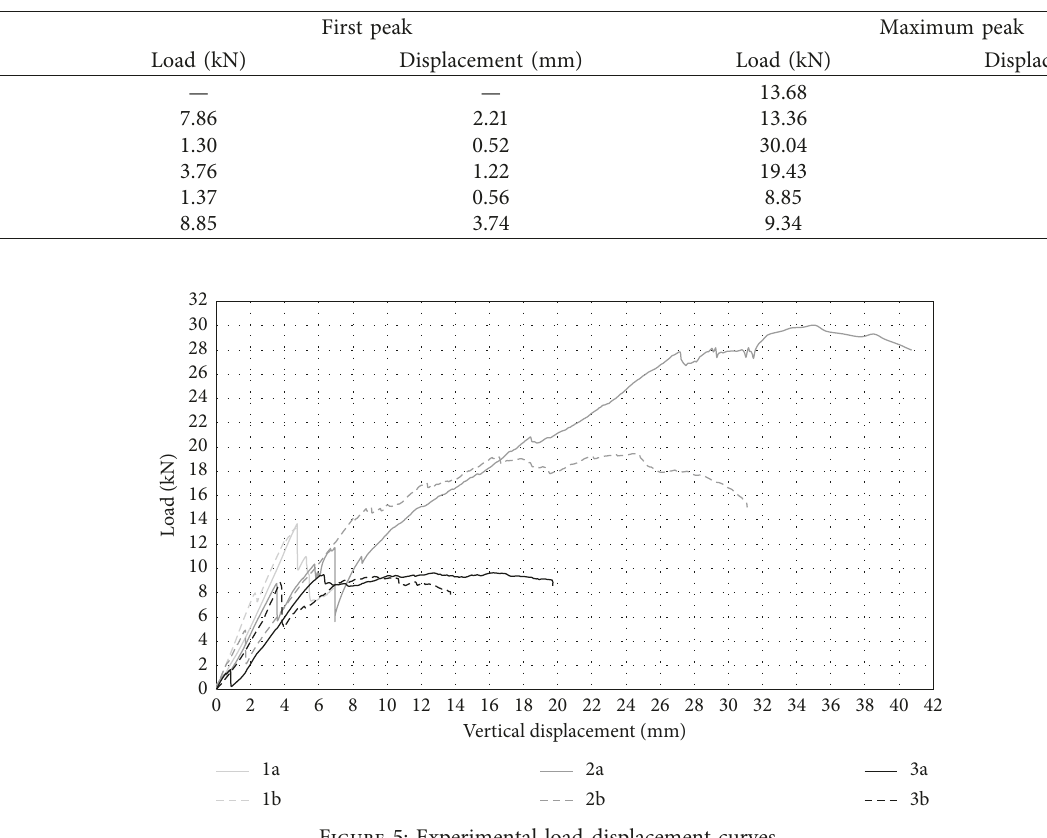
Figure 4: Sample 2a placed in the testing machine, before the application of the load. Table 3: Test results.